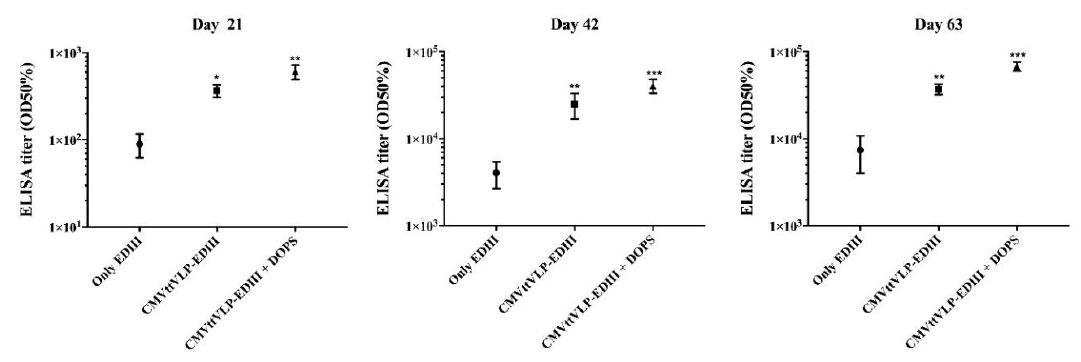
Figure 2. CuMVtt-EDIII formulated in DOPS indices highest total IgG responses. The figure shows IgGs level of three different groups of mice vaccinated with EDIII alone formulated in phosphate- buffered saline (PBS), with vaccine formulated by coupling EDIII to VLP (CuMVtt-EDIII) or formulating CuMVtt-EDIII plus DOPS adjuvant. The assessment was done with sera collected three weeks after each vaccination. The results were analysed using GraphPad Prism software applied to assess the means of three groups by one-way analysis of variance (ANOVA). The values observed in the negative control group (vaccinated with only PBS) were subtracted from the titres of the other experimental groups. Note: * p < 0.01, ** p < 0.001, *** p < 0.0001.